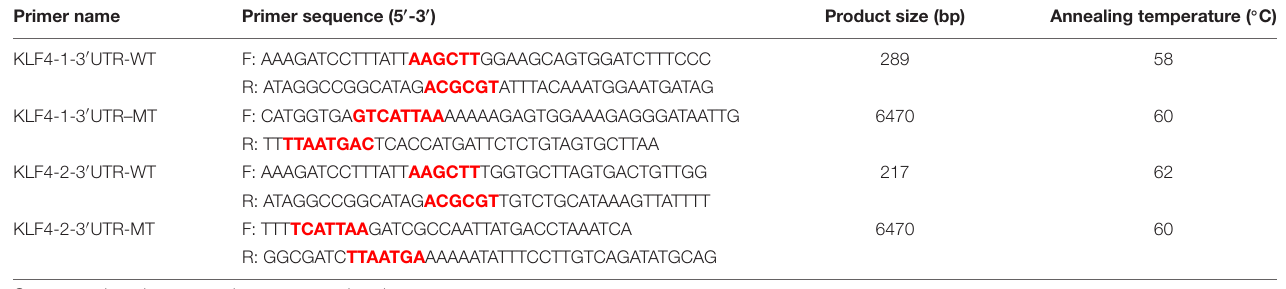
TABLE 4 | Primers used for vector construction.